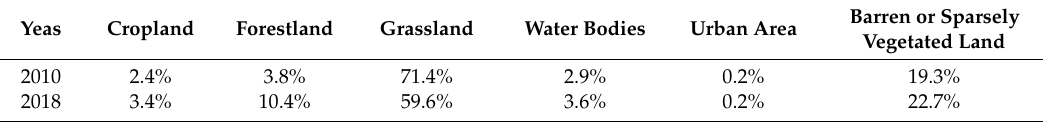
Table 6. Land-use changes in the N–Y sub-catchment in 2010 and